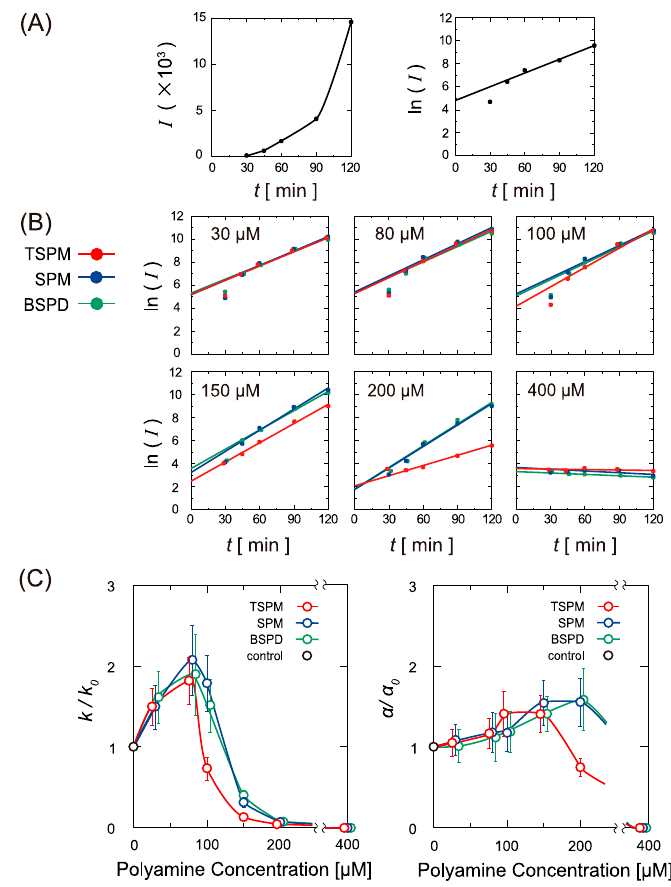
Figure 4. ( A ) Left: Temporal changes in gene expression up to t = 120 min in the absence of polyamine, where I is the luminescence intensity evaluated through a luminometer. Right: Logarithm of the luminescence intensity, ln( I ), vs. time, t , indicating a nearly linear relationship between t = 45 and 120 min. The slope gives the reaction constant with an exponential increase in the product of gene expression. ( B ) Logarithm of the luminescence intensity, ln( I ), vs. time, t , for the experimental data in the presence of different concentrations of the polyamines. ( C ) Relative rate constants, k / k 0 and α / α 0 , as the pre-exponential and exponential parameters in Equation (1) for gene expression as a function of the polyamine concentration. The rate constants in the absence of the polyamine are k 0 = 4.9 min − 1 and α 0 = 0.039 min − 1 . Error bar was estimated based on the consideration of error propagation